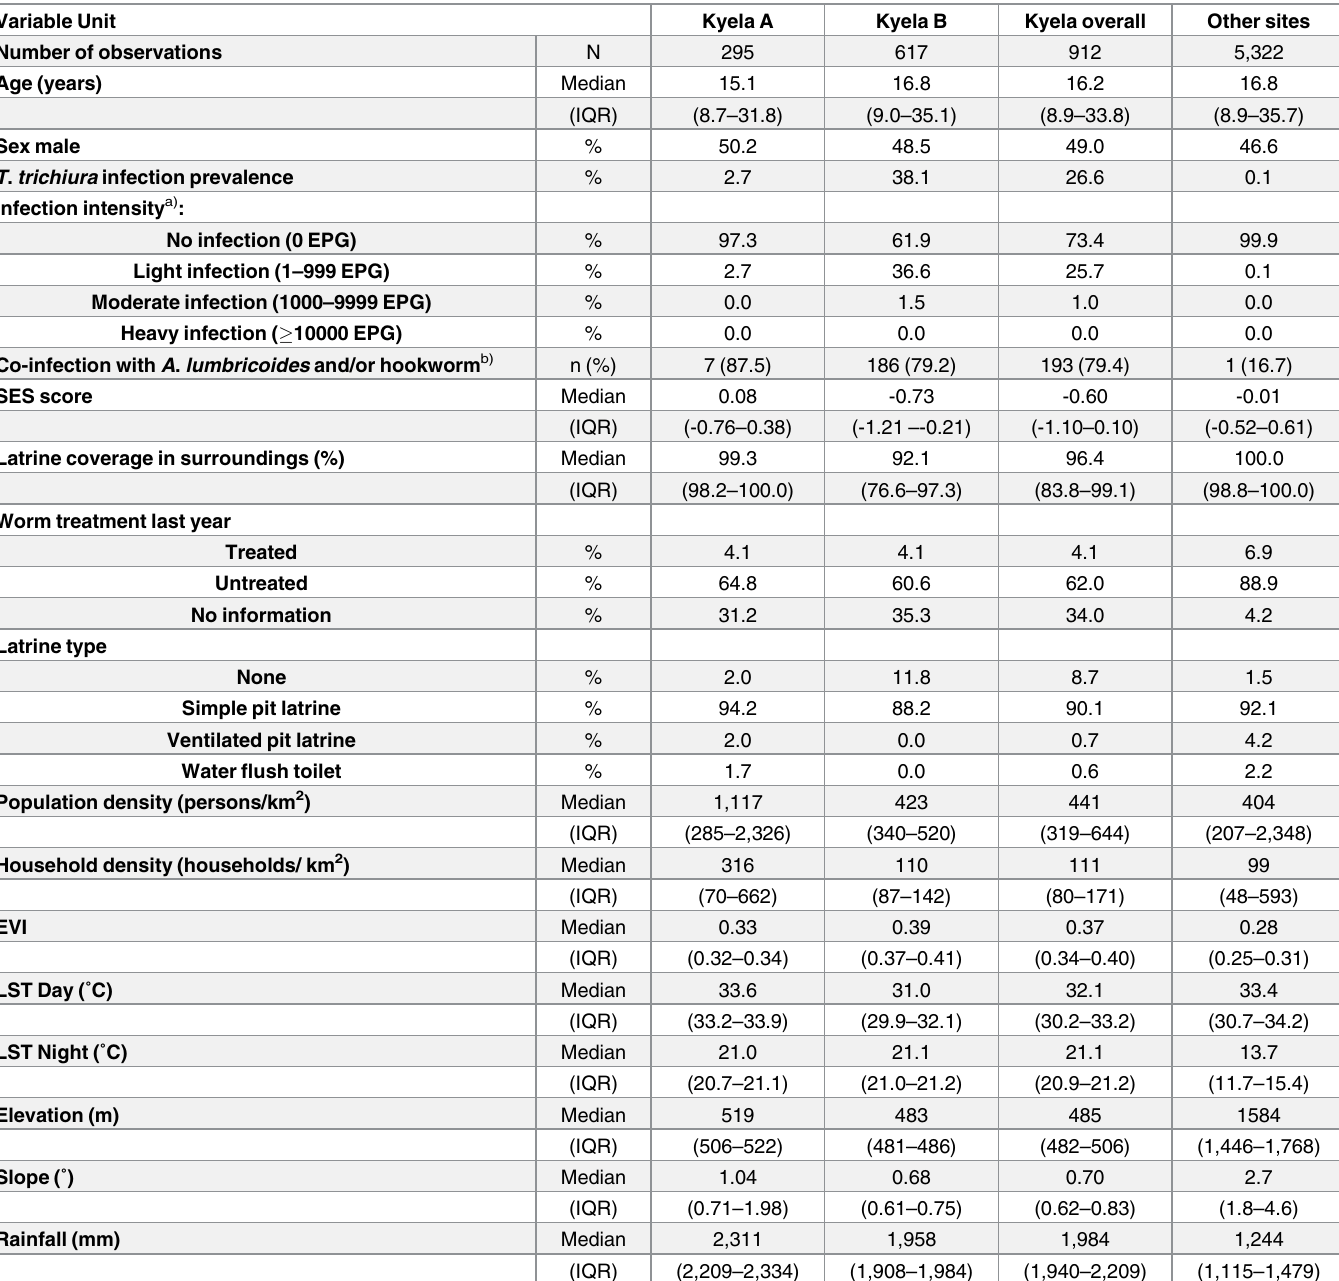
Table 1. Characteristics of the study population and environmental conditions at their place of